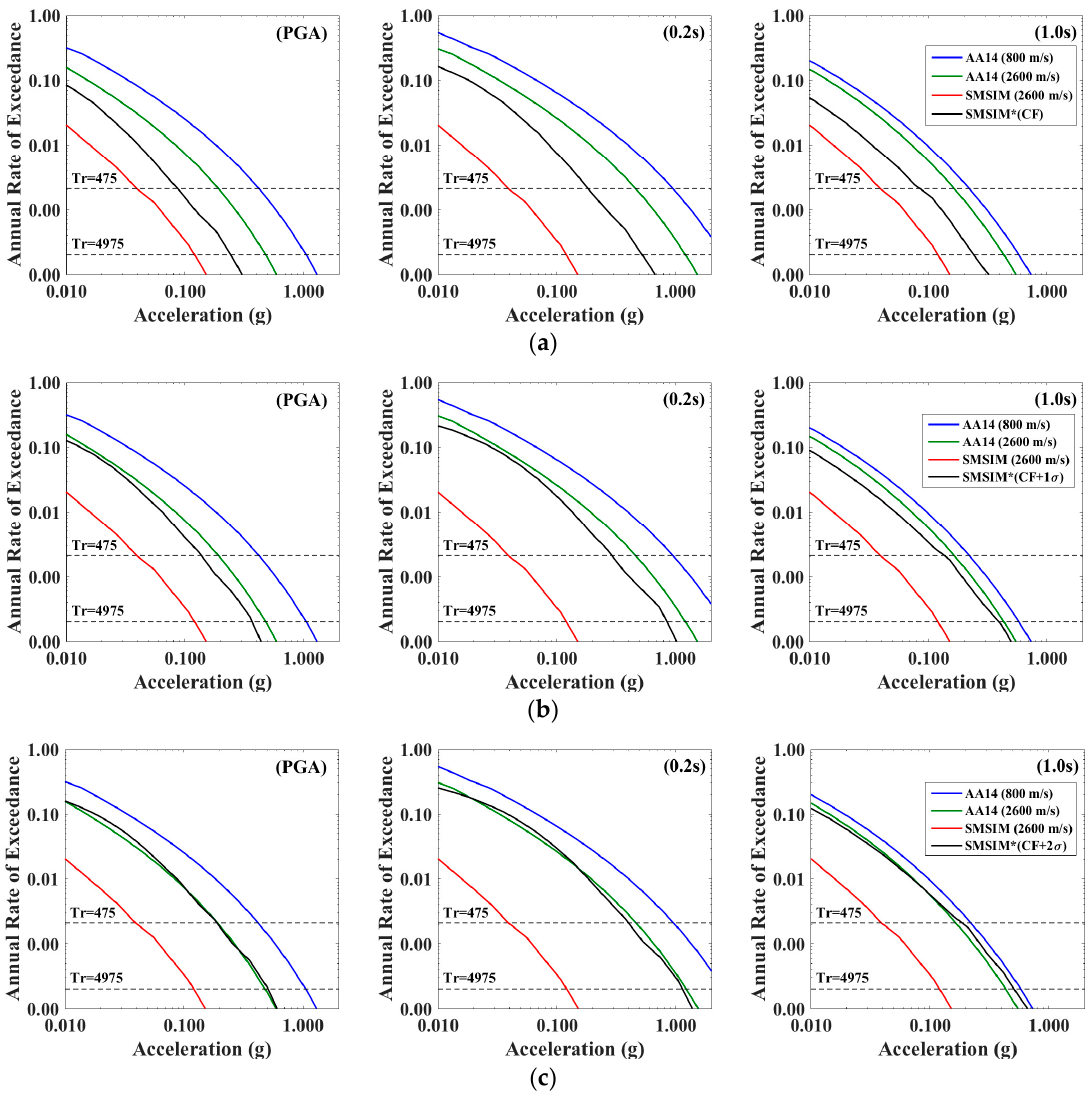
Figure 9. In black, hazard curves for three spectral periods (PGA, 0.2 s, 1.0 s) built from SMSIM stochastic time histories scaled by the: ( a ) Median correction factor (CF), ( b ) Median + one standard deviation correction factor (CF+1 σ ), ( c ) Median + two standard deviation correction factor (CF+2 σ ). Also superimposed the hazard curves obtained with AA14 at V S30 = 800 m/s (blue), hazard curves obtained with AA14 corrected at V S30 = 2600 m/s (green), and hazard curves derived from SMSIM original time histories (red).